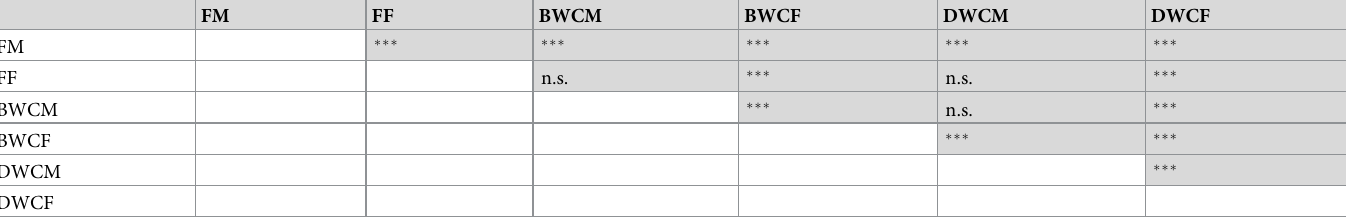
Table 2. Tukey’s pairwise test was conducted to test for significant differences in mean body length excluding the tails of farm males (FM), farmed females (FF), Bornholm wild caught males (BWCM) and females (BWCF), mainland Denmark wild caught males (DWCM) and females (DWCF) ( ��� = p < 0.0001; n.s. = non- significant) from samples collected from